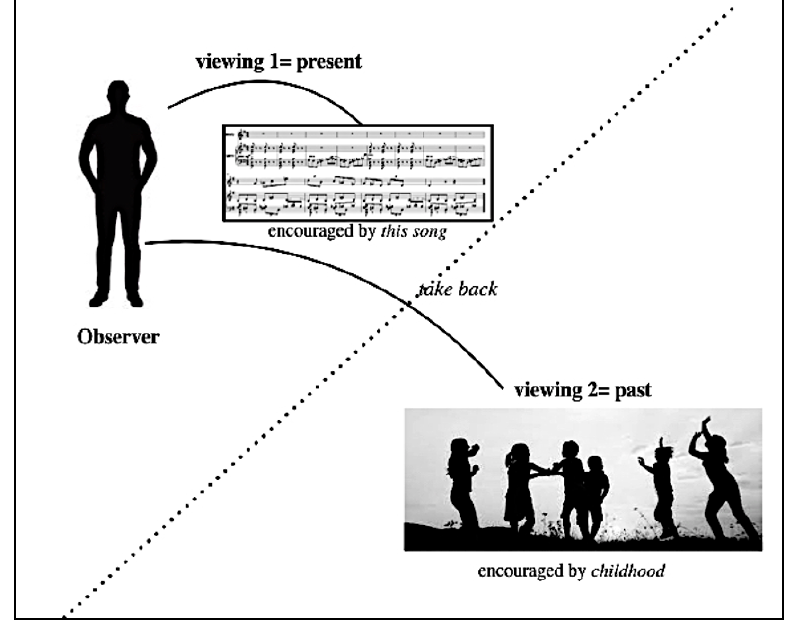
linear order image